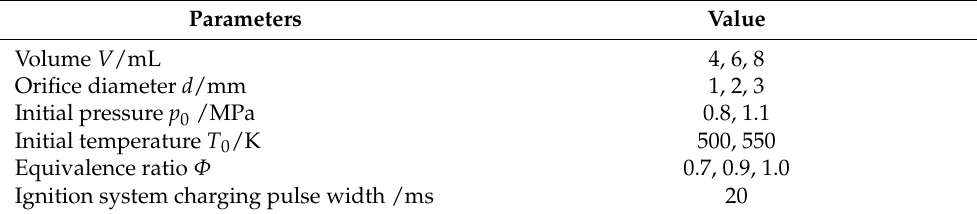
Table 1. Experimental parameters.